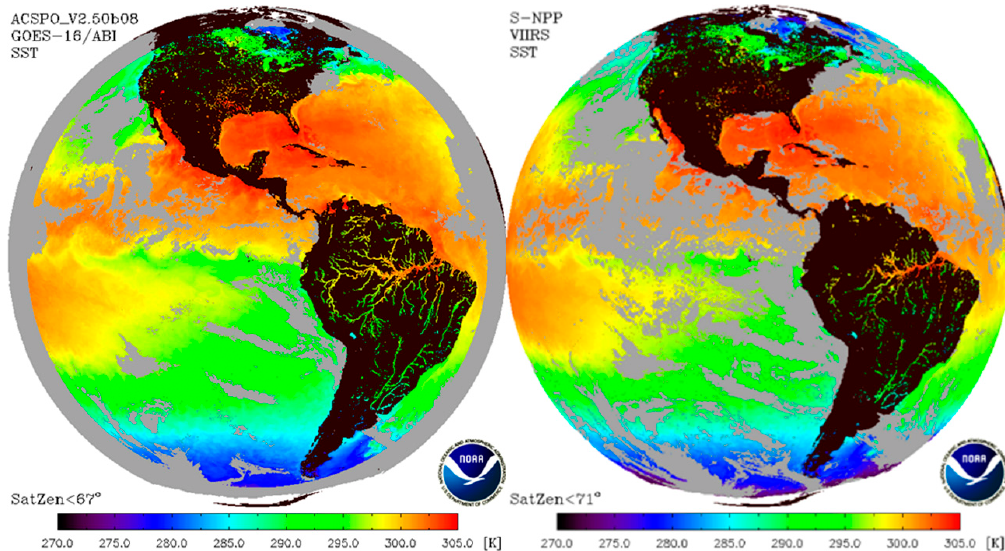
Figure 5. The ACSPO enterprise algorithm produces consistent results when applied on GOES-16 ABI ( left ) and on the VIIRS ( right ) for nighttime composites in the same domain. Large areas are cloudy during the S-NPP night overpass at 1:30 am on 29 July 2017; the GOES-16 ABI nighttime composite picks up more clear areas due to the high temporal resolution (every 15 min). The VIIRS SST, on the other hand, provides global coverage, including the polar regions. (Figure courtesy: Alex Ignatov, STAR SST team).